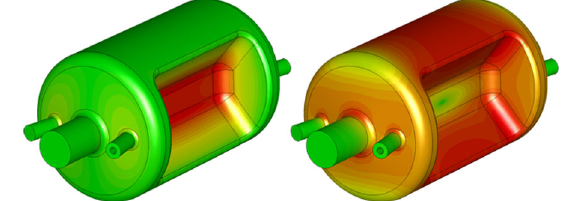
FIG. 3. Surface electric (left) and magnetic (right) fields in the rf-dipole cavity.